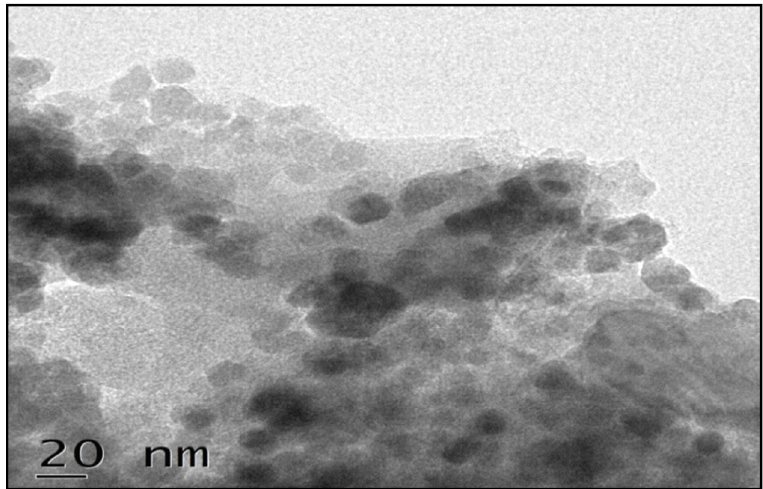
Figure 1. TEM image of Fe 3 O 4 /AC/CD/Alg polymer beads.